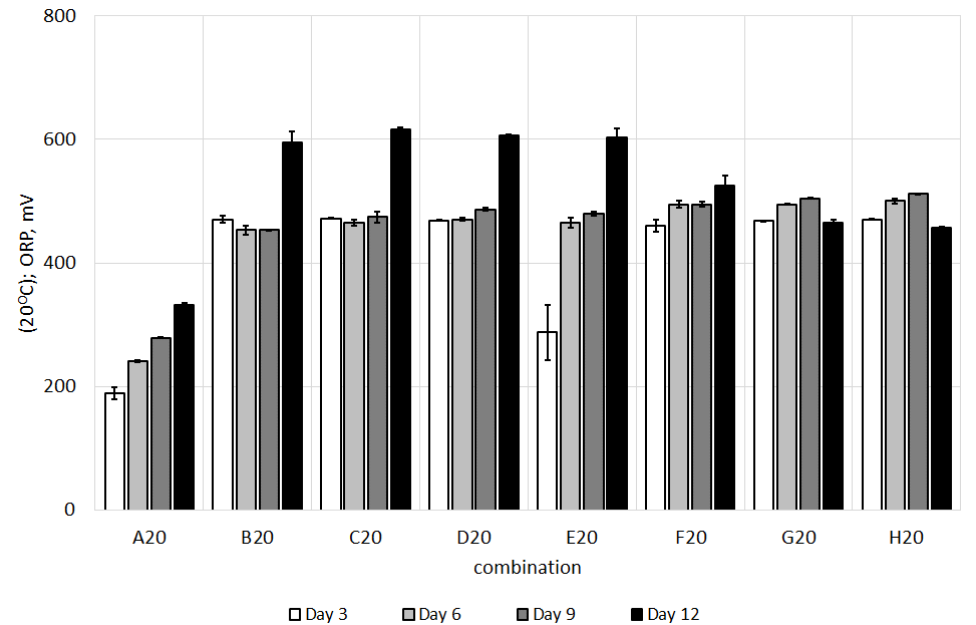
Figure 4. Oxidation reduction potential of samples incubated at 20 °C.